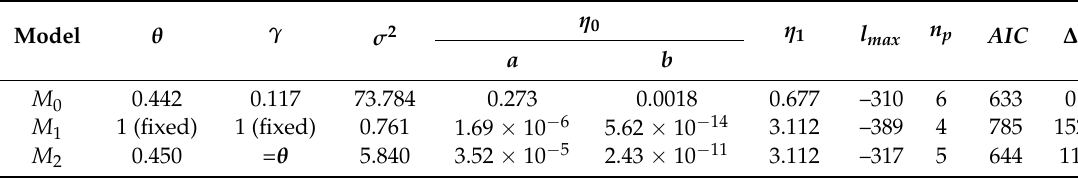
Table 3 . LED application: parameter estimates for three candidate models with random drift coefficients ( b ≠ 0).